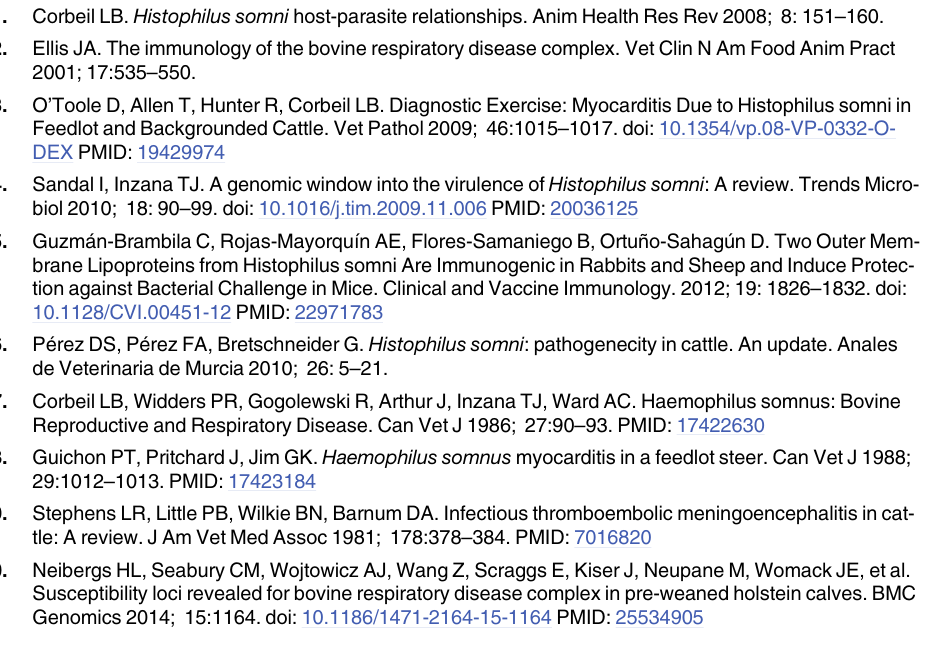
S2 Table. Statistical determination of serum antibodies using Mann Whitney test “ R ” is denoted for rank of gene or protein. The vaccine for group A (placebo/control group) did not contain antigens. The vaccine for groups B, C and D contained antigens (R2, R5, R8, R18, R27,